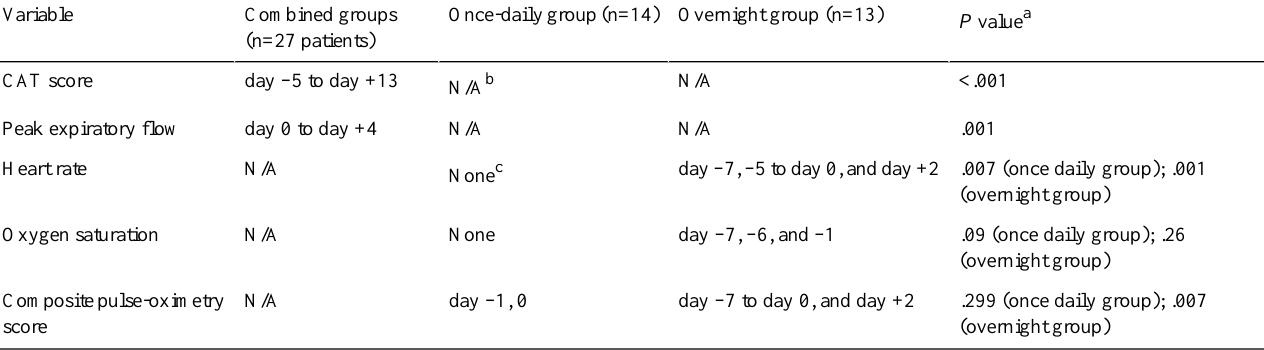
Table 2. Summary table reporting the days when variables showed statistically significant variation from baseline based on a difference of 1.96 SD units or more away from the stable-state